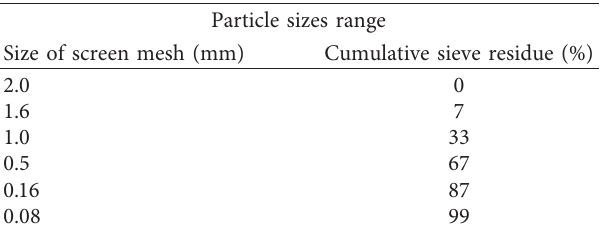
Table 3: Technical indicators of standard